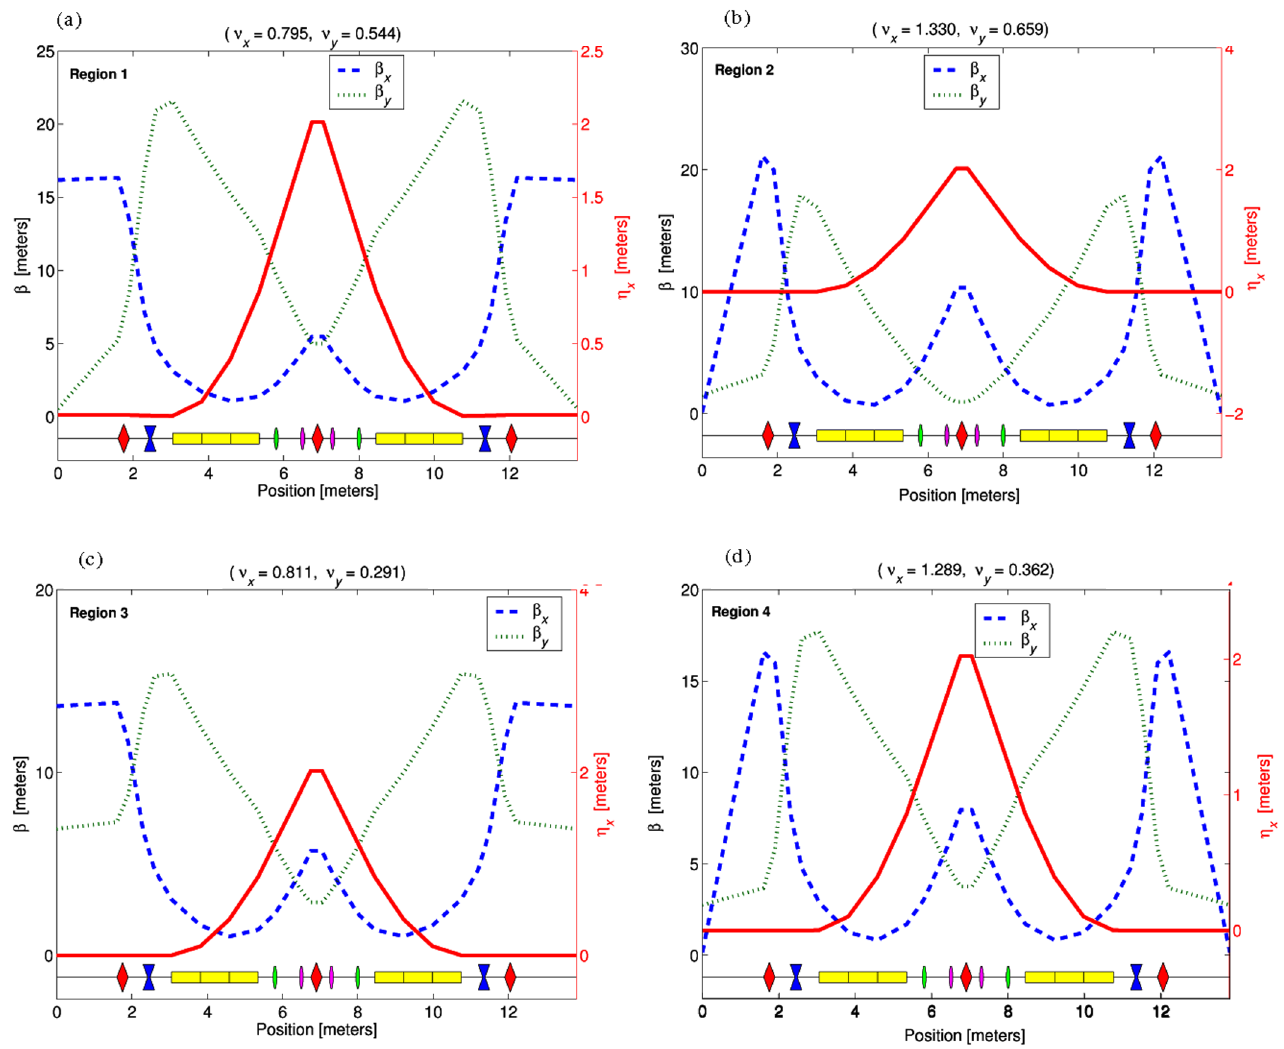
FIG. 16. (Color) A lattice of one of four CAMD DBA sectors and associated lattice functions in region 1 (top left), region 2 (top right), region 3 (bottom left), and region 4 (bottom right).